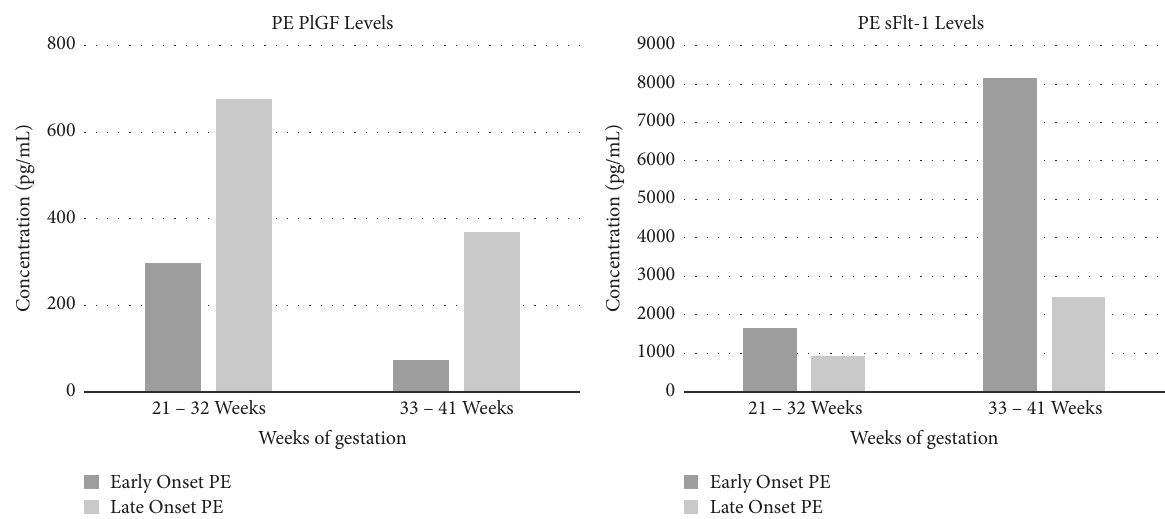
Figure 5: PlGF and sFlt-1 results obtained in women with early onset and late onset PE during different gestational periods [53].